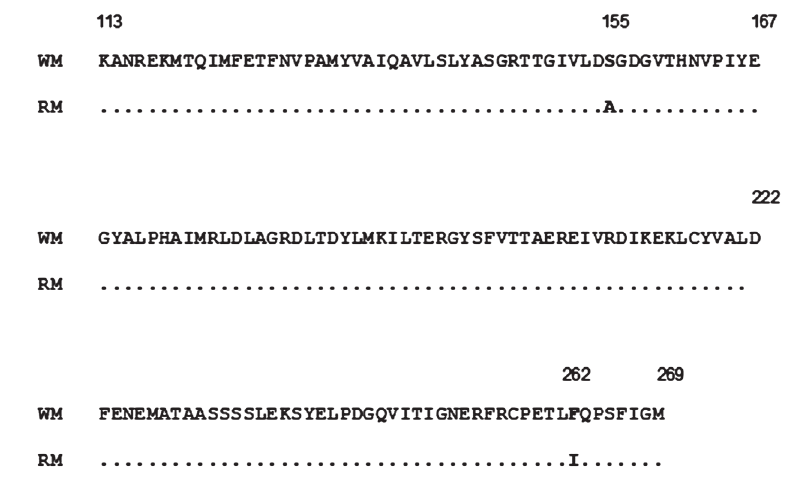
Figure 2 - Deduced amino acid sequences (residues 114-279) of the partial α -actin skeletal muscle genes isolated from white muscle (WM) and red muscle (RM) of Leporinus macrocephalus . Dots indicate identical amino acid residues. The 155 th and the 262 th residues are indicated by bold